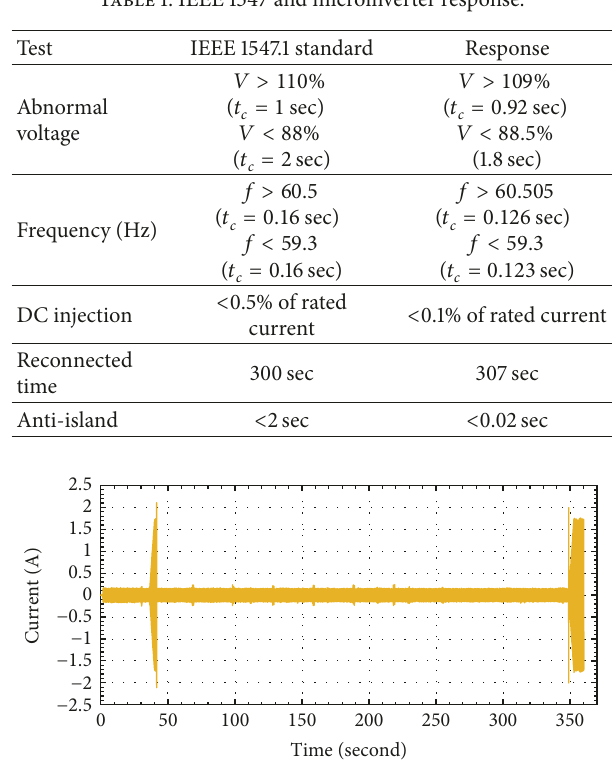
Figure 3: The output current of microinverter under reconnected time